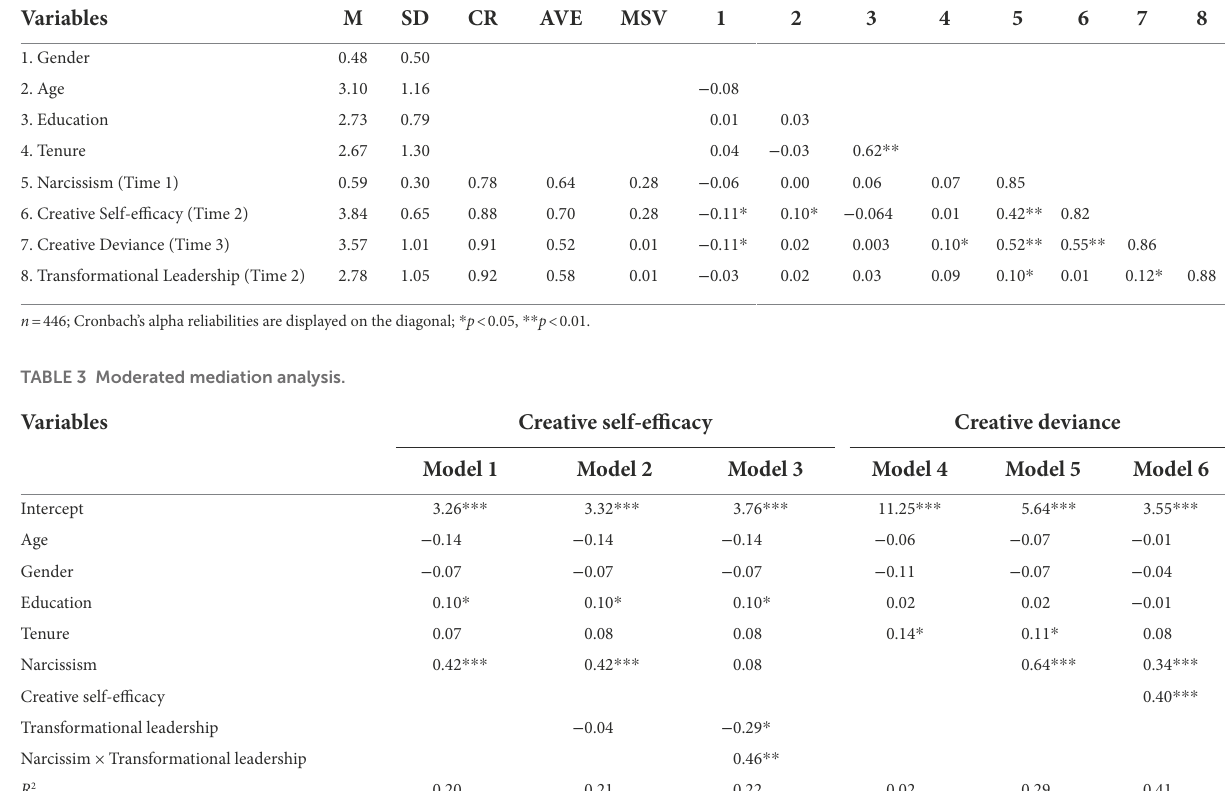
TABLE 2 Results of the descriptive statistical analysis.